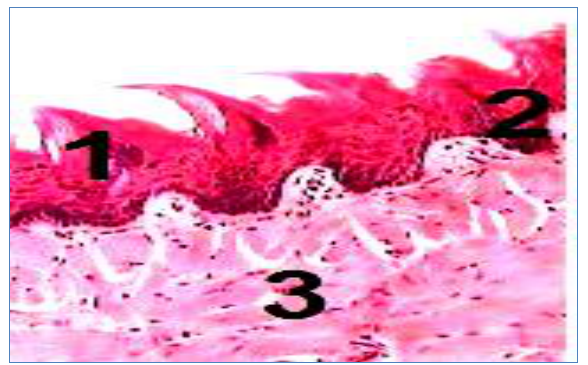
Figure, 7: Fungiform papillae of tongue Hystrix crestate (H and E) stain 100X.